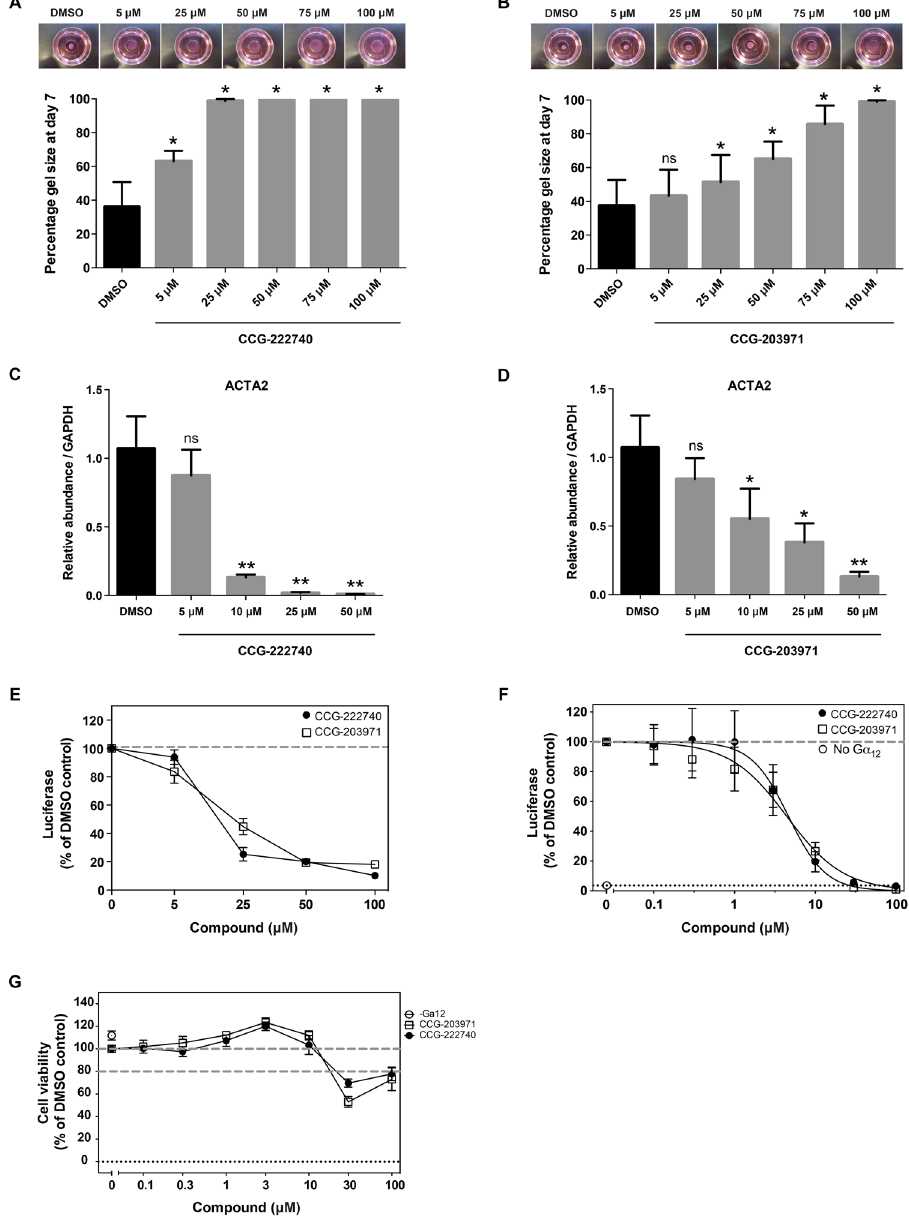
Figure 2. CCG-222740 is more effective than CCG-203971 in rabbit conjunctival fibroblasts. ( A , B ) Rabbit conjunctival fibroblasts were seeded in collagen type I matrix and cultured for 7 days as in Fig. 1A and B. ( C , D ) Analysis of ACTA2 gene expression in rabbit conjunctival fibroblasts was analysed by qRT-PCR as in Fig. 1E and F. Results represent mean ± SEM for triplicate experiments. * P < 0.05; ** P < 0.01. ( E ) Rabbit conjunctival fibroblasts were transfected with the SRF reporter 3DA.luc, serum-starved, and treated with different concentrations of CCG-222740 or CCG-203971 or 0.1% DMSO control for 24 hours. Results represent mean ± SEM for triplicate experiments; ( F ) HEK293 cells were transfected with the SRF reporter SRE.L luc and treated as in ( E ). Results represent mean ± SEM for triplicate experiments; ( G ) HEK293 cell viability in the presence of CCG-222740 or CCG-203971 was measured using the WST-1 assay. Results represent mean ± SEM for triplicate